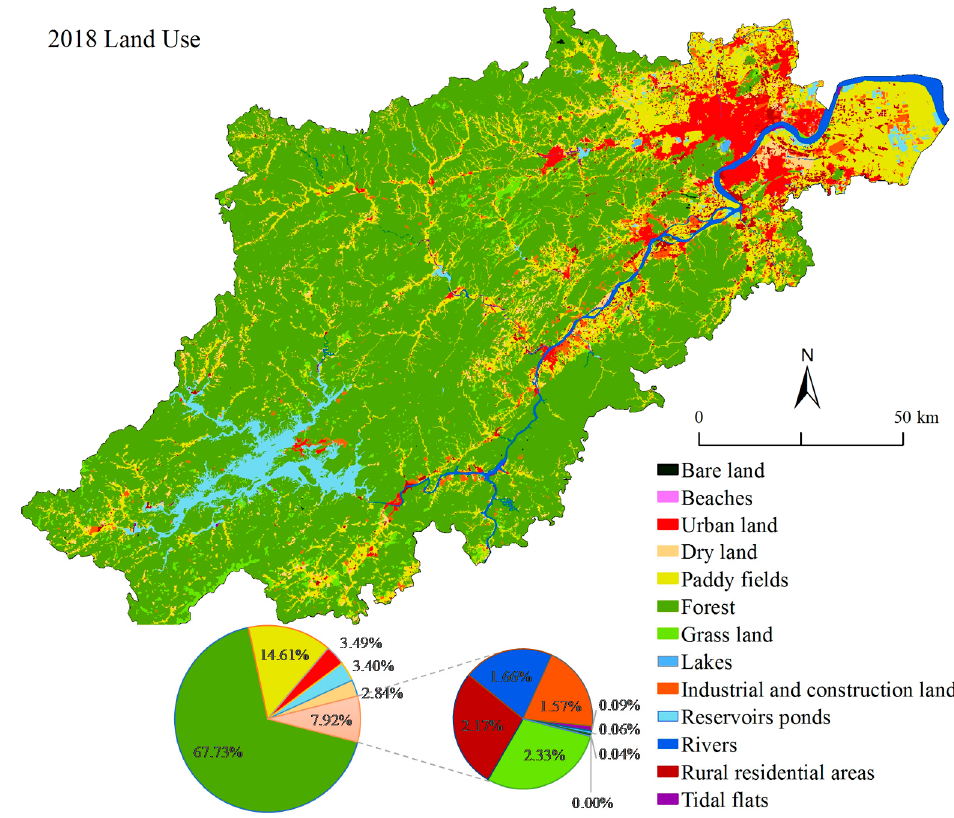
Figure A1. Spatial distribution of land use types in Hangzhou.